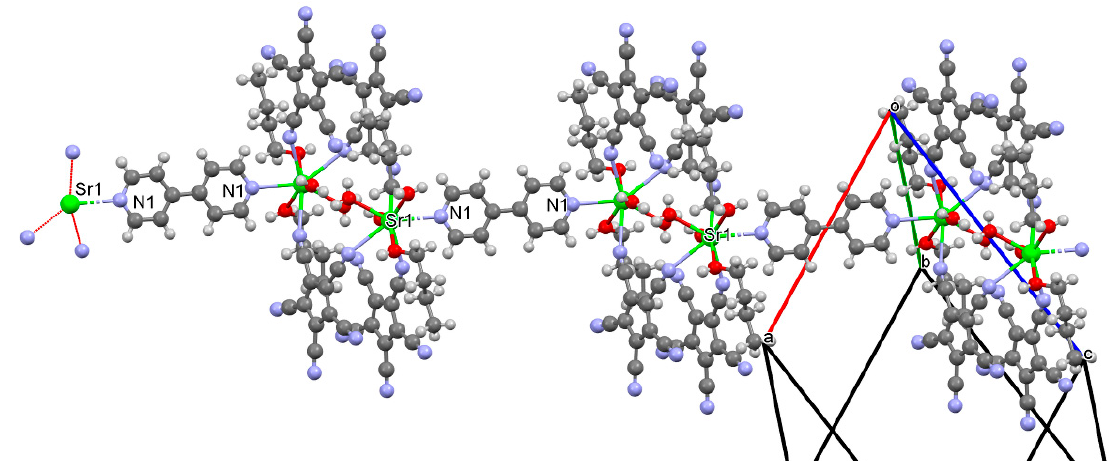
Figure 17 . The linear 4,4 ′ -bipy-bridged arrangement of the dimeric subunits of Figure 16. The two remaining 4,4 ′ -bipy molecules fill the voids between the polymeric chains (Figure 18). One of them (containing N11/ N12, blue-colored in Figure 18)) is nearly planar (angle between the two molecule halves 1.3 (1)°, while the other (containing N21/ N22, red-colored in Figure 18)) is severely twisted (interplanar angle 33.6 (2)°). Two symmetry related “blue” bipyridines show weak π -stacking (distance between centroids ca. 3.83 Å with a perpendicular distance of ca. 3.45 Å). There is also weak π -stacking between a “red” and a “blue” bipyridine (centroid distance ca. 3.77 Å, perpendicular distance 3.62 Å) and between a “red” and a ”green” bipyridine (centroid distance ca, 3.70, perpendicular distance ca. 3.17 Å).